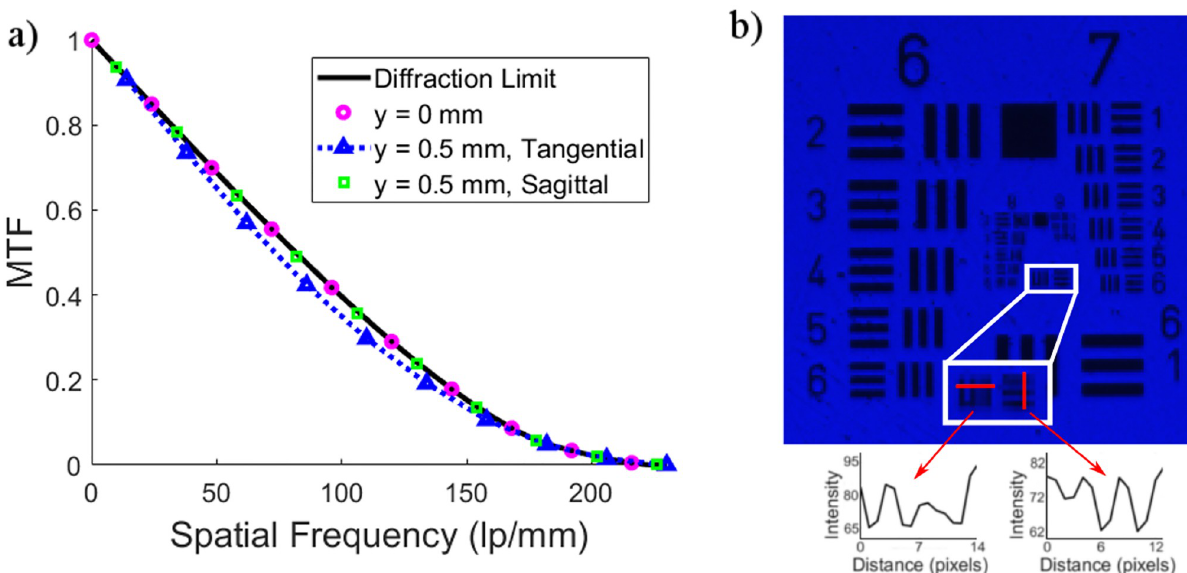
Fig 2. Performance of the assembled fluorescence microscope. (a) MTF plot calculated for the image plane in both the tangential and sagittal directions showing the nominal performance of the system. (b) Image taken with a 455 nm LED of a high resolution 1951 USAF target presenting the measured performance of the system. The smallest resolvable feature on the target was group 8 element 1 (shown enlarged and outlined in white), demonstrated by the intensity profiles through the vertical and horizontal elements indicated by the red lines and arrows. Resolution target image has been contrast enhanced for visualization